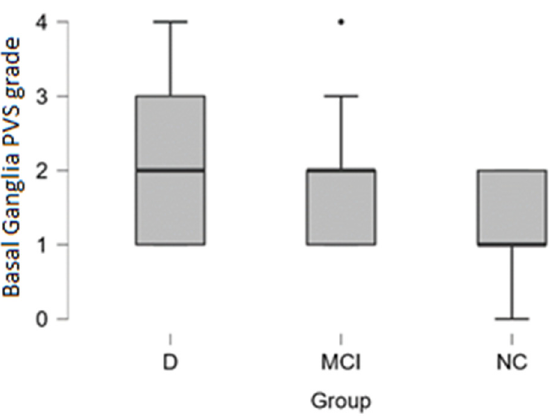
Figure 5. Basal ganglia PVS dilatation grade boxplot in (from left to right) dementia, MCI, and normal cognition groups (black dot, outlier).